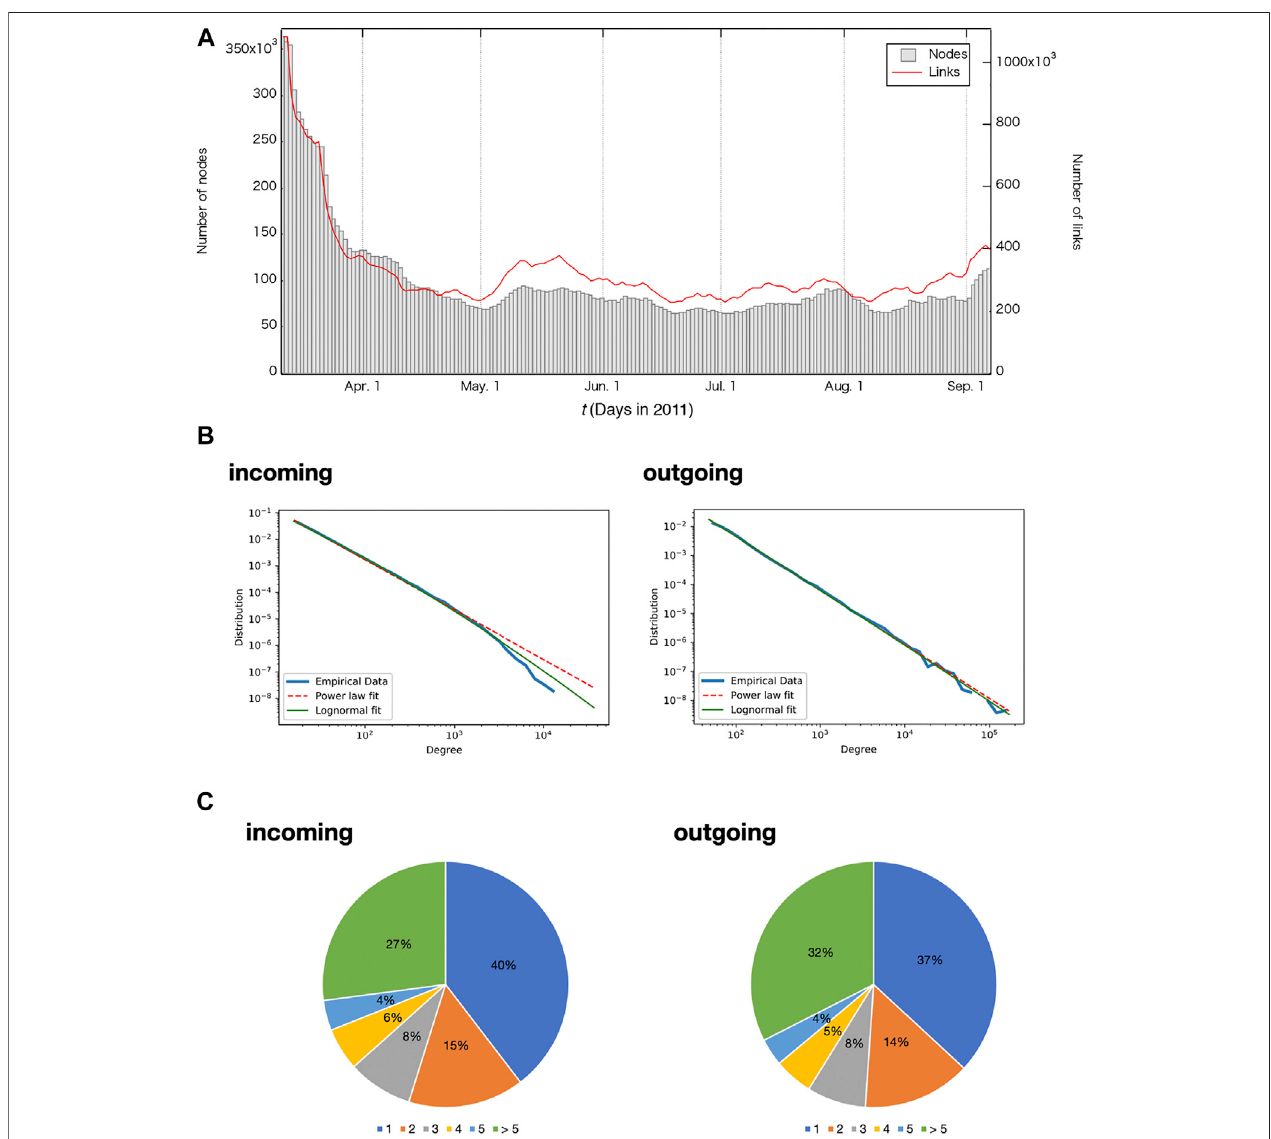
FIGURE 2 | (A) The number of nodes and links of the retweet network built from the radiation-related tweets after the 1F accident per week. There were large numbers of nodes and links immediately after the 1F accident but gradually decreased with time. (B) Degree distribution of both incoming (retweeted) and outgoing (retweet) link. For incoming link, lognormal distribution (green solid line) is selected p < 0.01 while outgoing link distribution is not statistically selected. Power-law exponent is 1.93 for incoming link and 1.87 for outgoing link in the fi gure. (C) Pie chart of the number of links in the retweet network for the whole observed period. More than half of the nodes have less than two in both incoming and outgoing